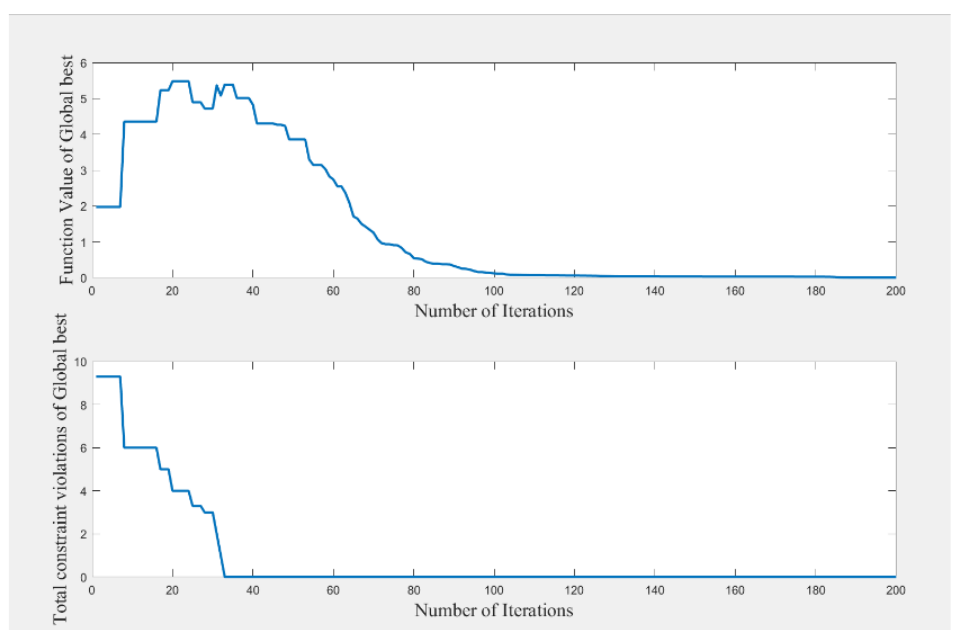
Figure 4. Optimization iterative diagram.